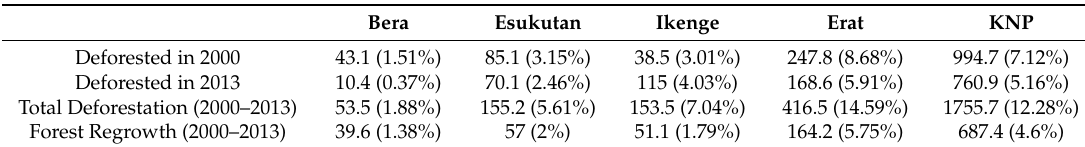
Table 2. Area (Ha) and Percent (%) Deforested and Regrowth in the Korup National Park between 2000 and